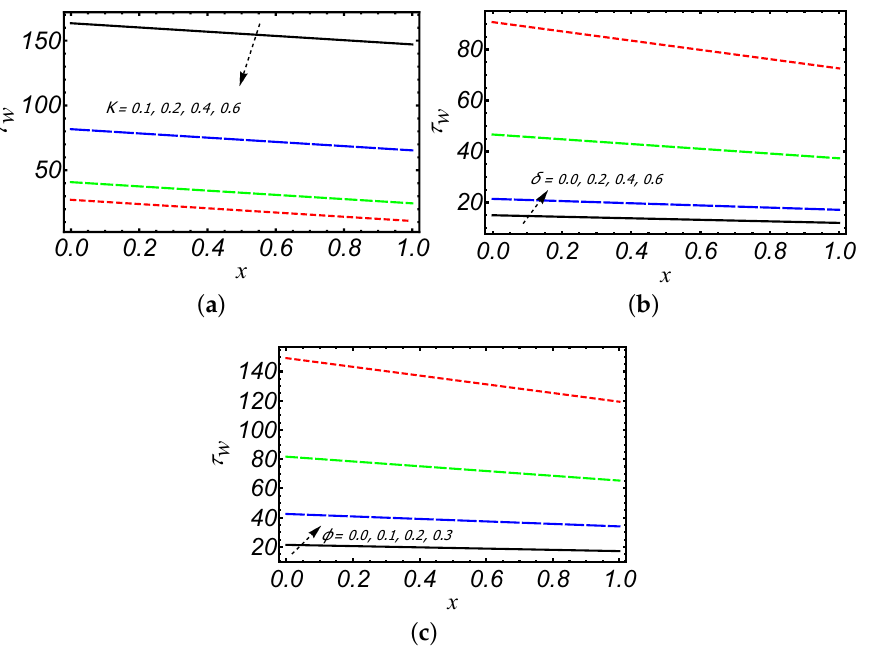
Figure 11. Behavior of τ w with ( a ) K when φ = δ = 0.2, ( b ) δ when K = δ = 0.2, ( c ) φ when K = δ = 0.2. It is also noted in Figure 12a that porosity K does not affect the normal stress difference τ n away from boundaries but τ n decreases near the walls with K and also in Figure 12b,c τ n decreases on increasing δ and φ . Figure 13 shows the variation of Q ( x ) and it is depicted that Q ( x ) decreases as we increased porosity K whereas it is increasing as we increase parameters δ and φ